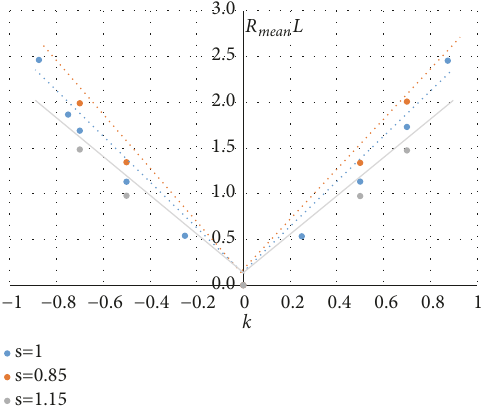
Figure 12: Trend of the 𝐴 𝑟 % when k and s